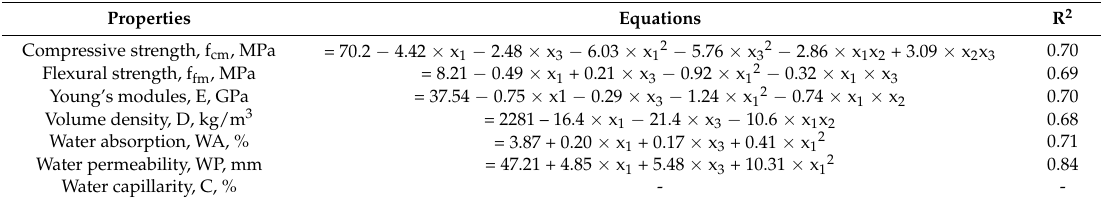
Table 10. The equations list for each properties of concrete.